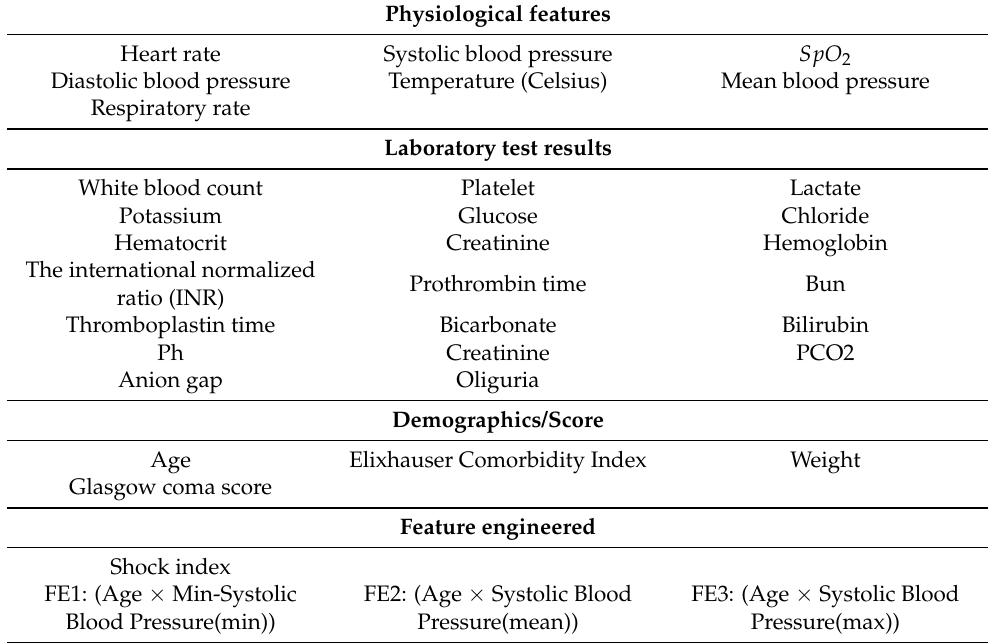
Table 2. Final feature subset.